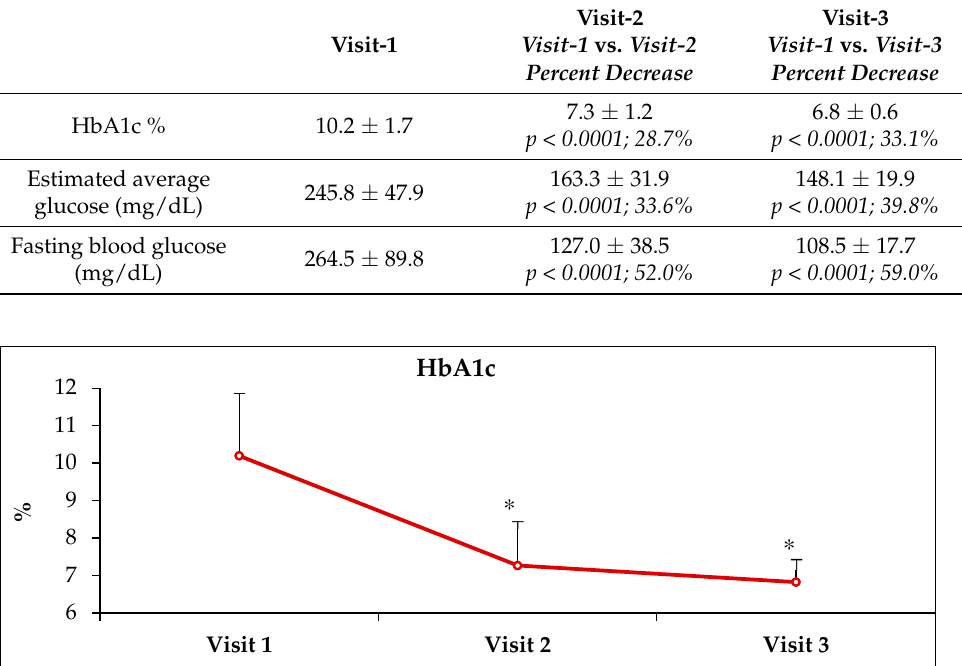
Figure 1. Improvement in glycosylated hemoglobin (HbA1c) after receiving ABCDE. Visit-1 = first visit where ABCDE was provided; Visit-2 and Visit-3 = visits 3- and 6 months after Visit-1. * = p < 0.00001.